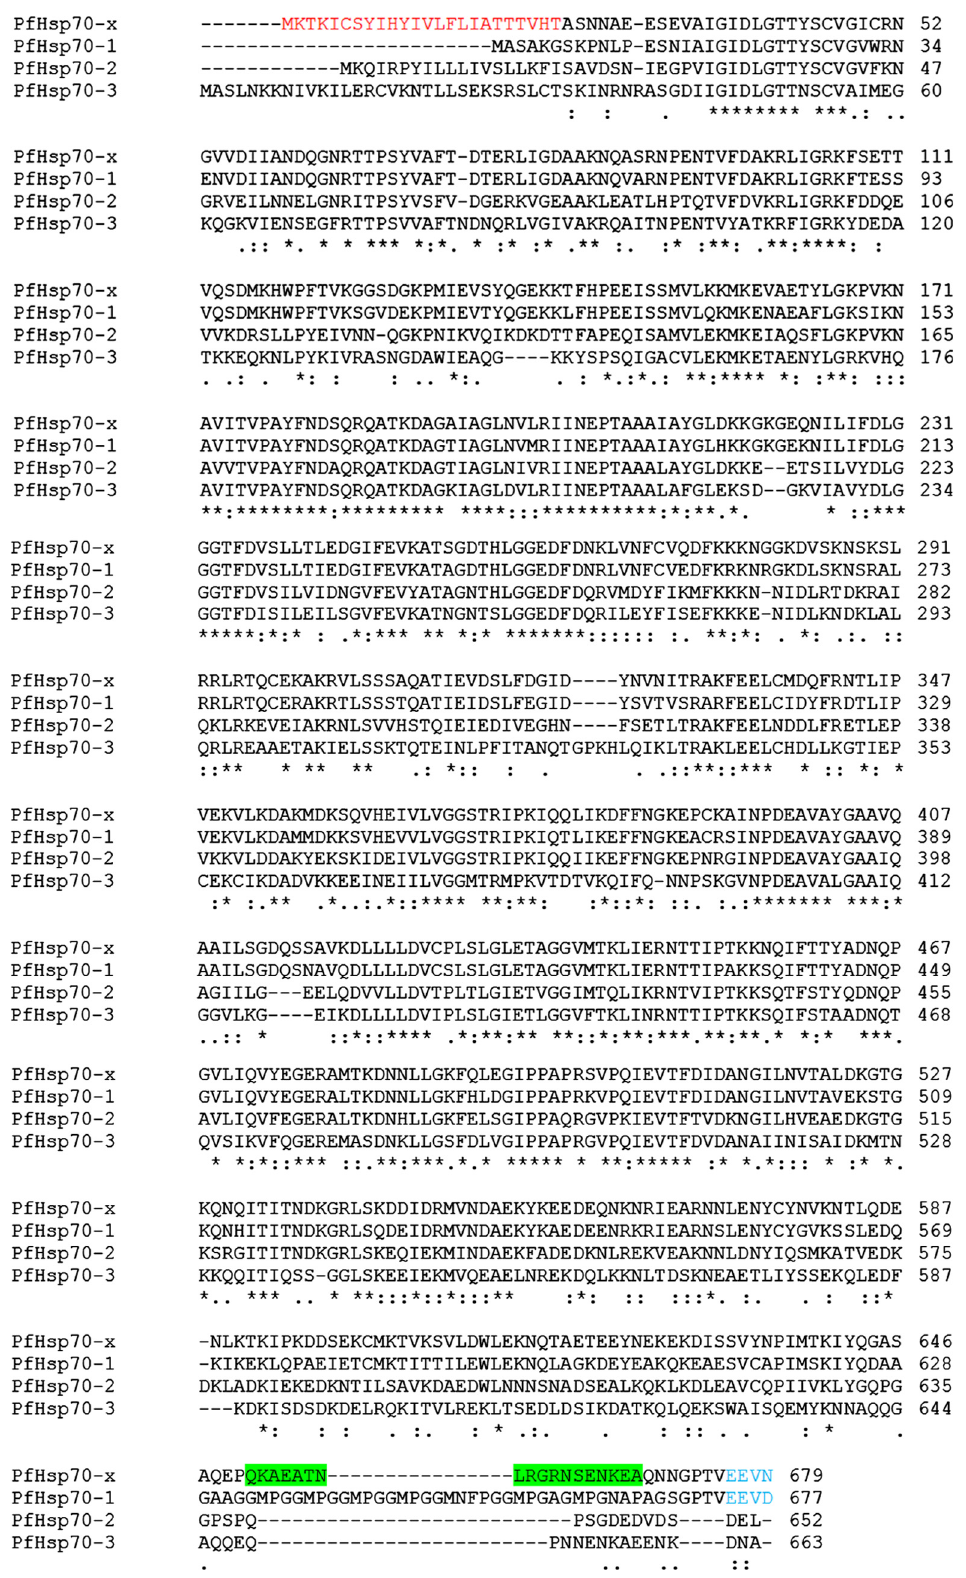
Figure 2. Sequence alignment of Hsp70s in P. falciparum : PfHsp70- x is aligned with PfHsp70-1 (cytosolic), PfHsp70-2 (ER) and PfHsp70-3 (mitochondrial) using ClustalW. Red: putative signal peptide, blue: EEVD/EEVN motif, green: peptide used to raise specific antiserum against PfHsp70- x in both mice and